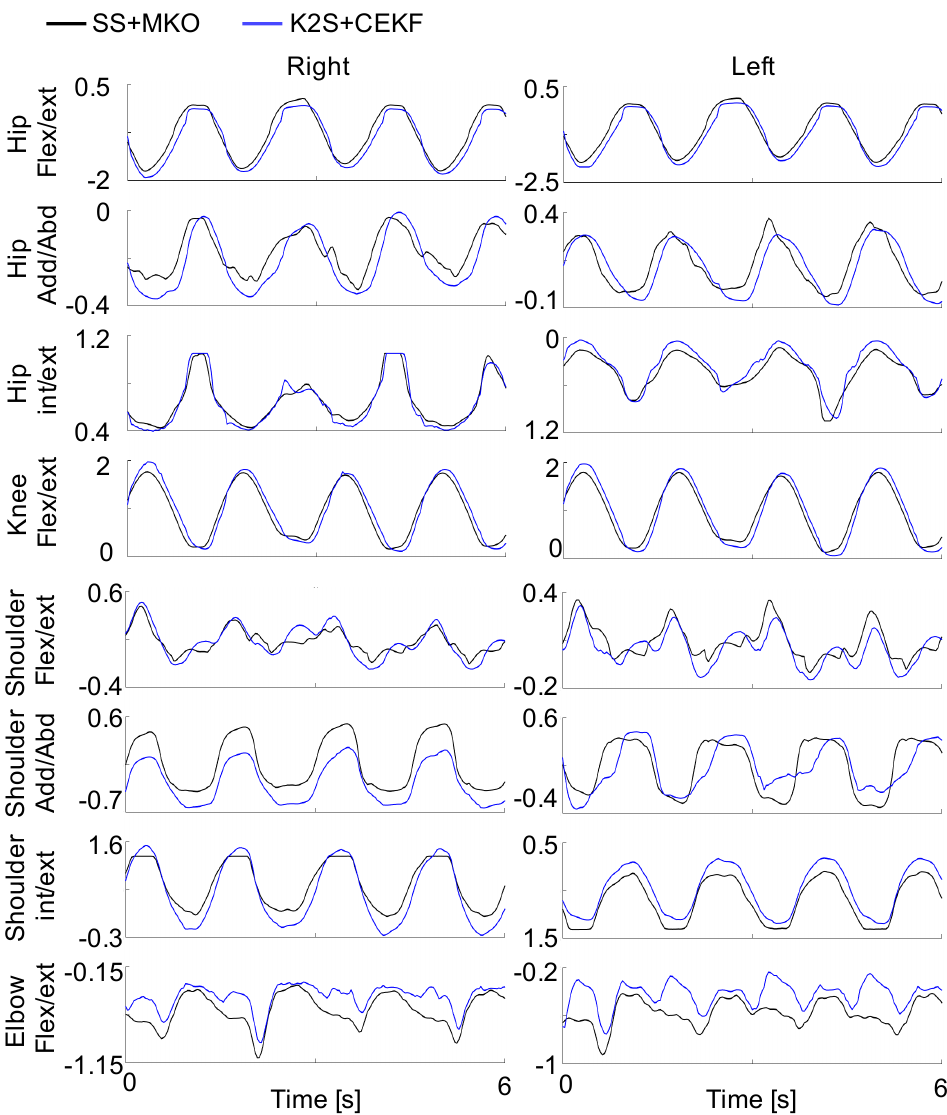
Figure 4. Representative comparison of joint trajectories estimated using the K2S and the proposed constrained extended Kalman filter (CEKF) (blue) and the SS and multibody kinetic optimization (MKO) (black) during the squat task. Flex/ext, int/ext and add/abd represent flexion/extension, internal/external rotation and adduction/abduction,